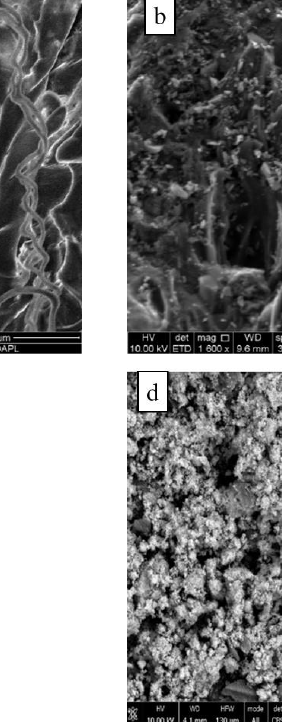
Figure 2. Scanning electron microscopy images for ( a ) raw Luffa, ( b ) LAC ( c ) TiLAC-7/3 and ( d ) TiLAC-9/1 (with high vacuum mode (pressure range 10 −2– 10 −4 Pa), imaging resolution of 1.0 nm for ‘a’ and ‘b’ and 0.8 for ‘c’ and ‘d’ at 10 kV, mode secondary electron image SE, integrated monochromator (UC) and beam deceleration mode. ETD detectors).